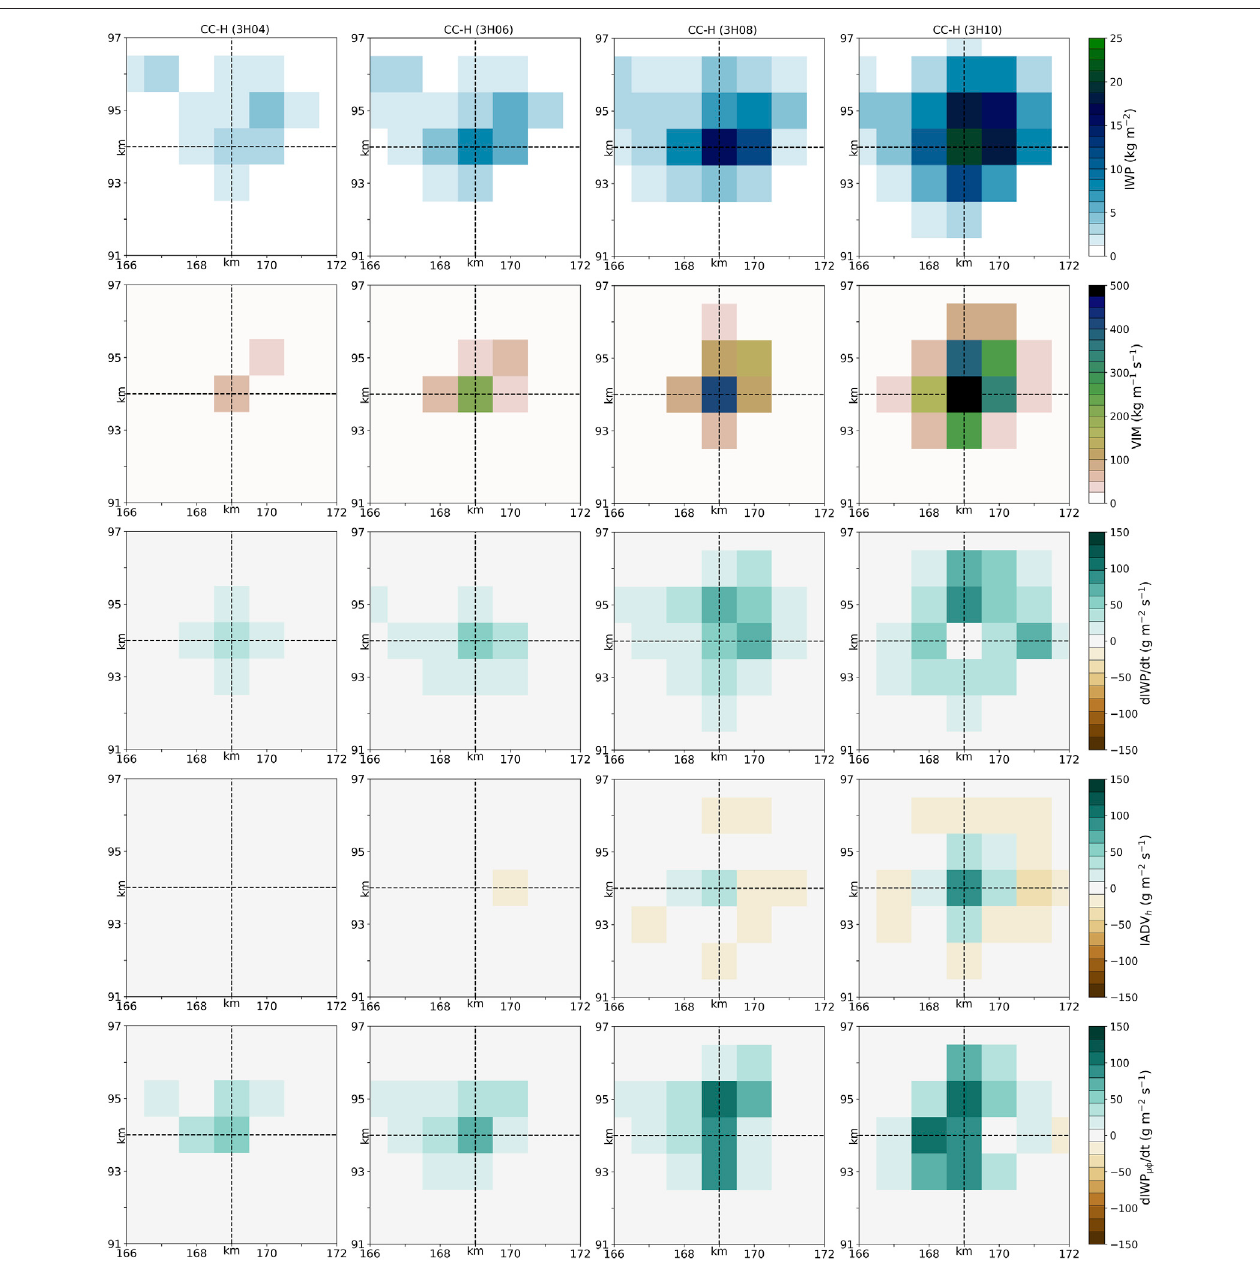
FIGURE4| HorizontalcrosssectionofIWP,VIM,dIWP/dt,IADV h ,anddIWP μ ϕ /dt(fromtoptobottom)atfourtimesspaced2-minapart(fromlefttoright)duringthe growth of CC-H (HEC simulation). The crossing of the dashed lines locates the core of CC-H.